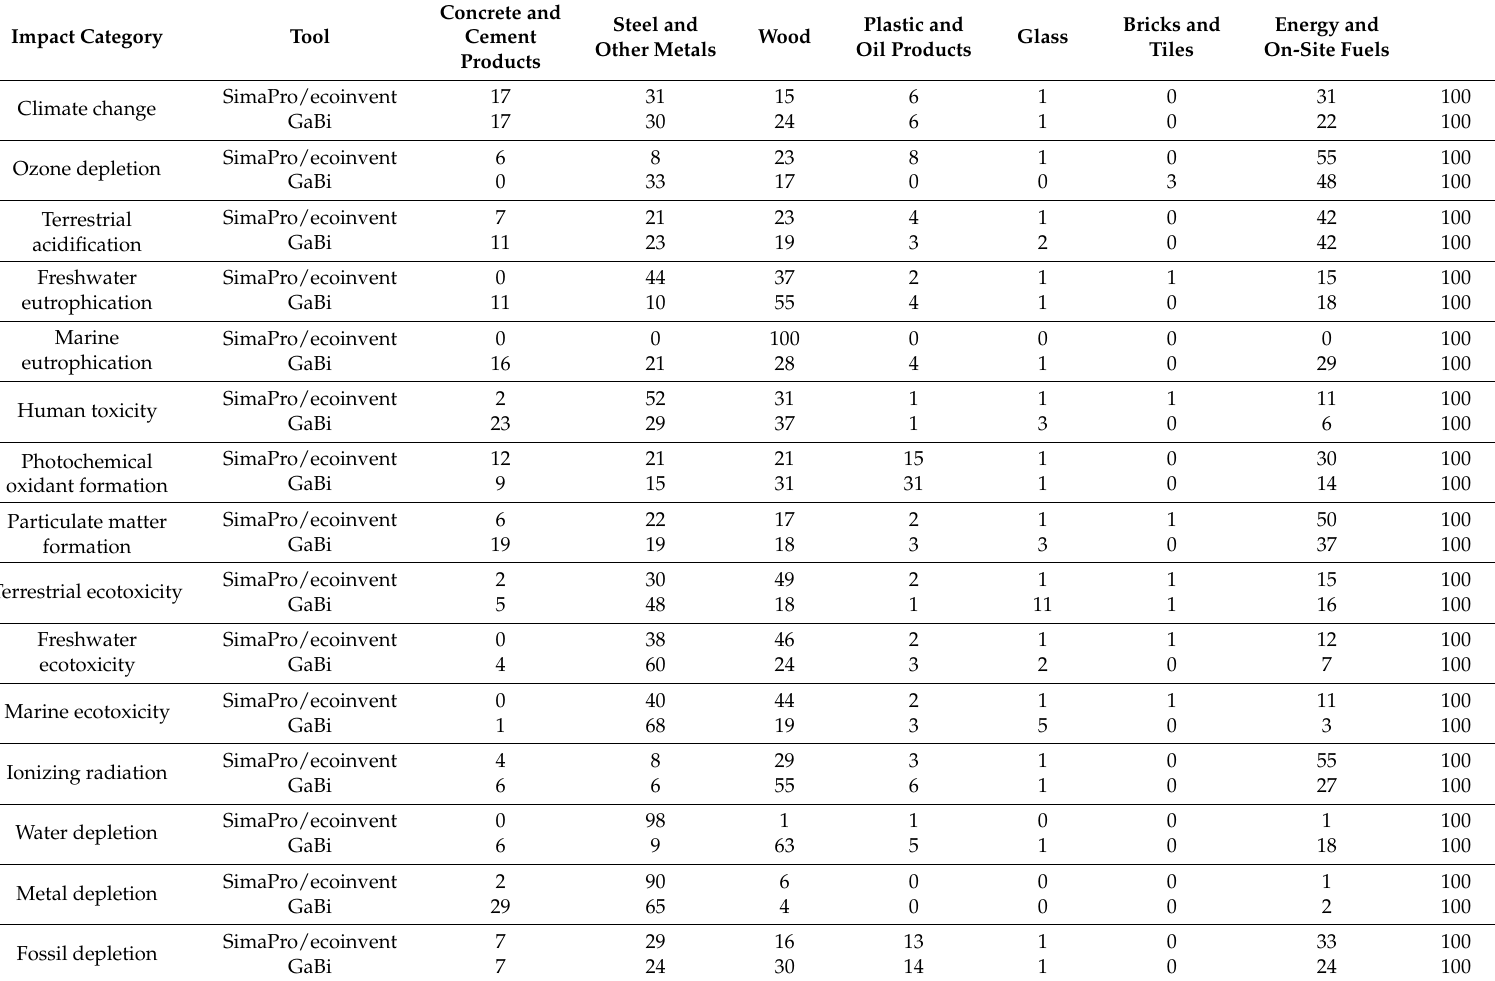
Table 5. Comparison for KÄPYLÄ of the importance of different material categories in the 15 impact categories between SimaPro/ecoinvent and GaBi. Weight of each category shown in